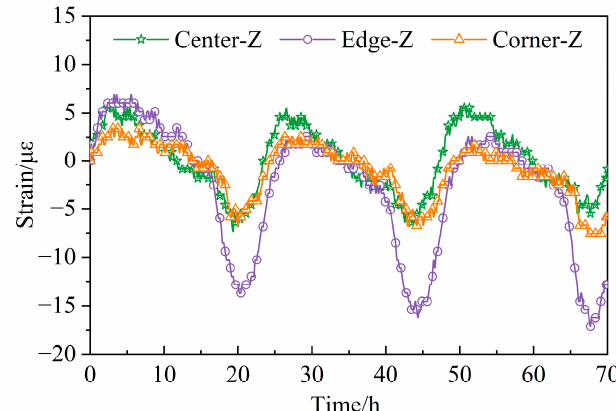
Figure 9. Vertical strain time history curve of RCP.